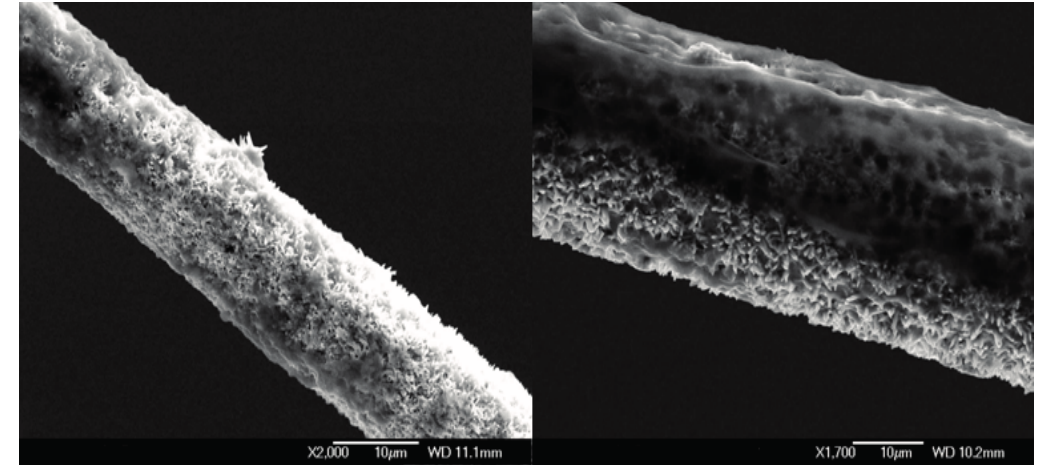
Figure 6. Scanning electron microscopy images showing the working electrode after intracellular measurements at two different